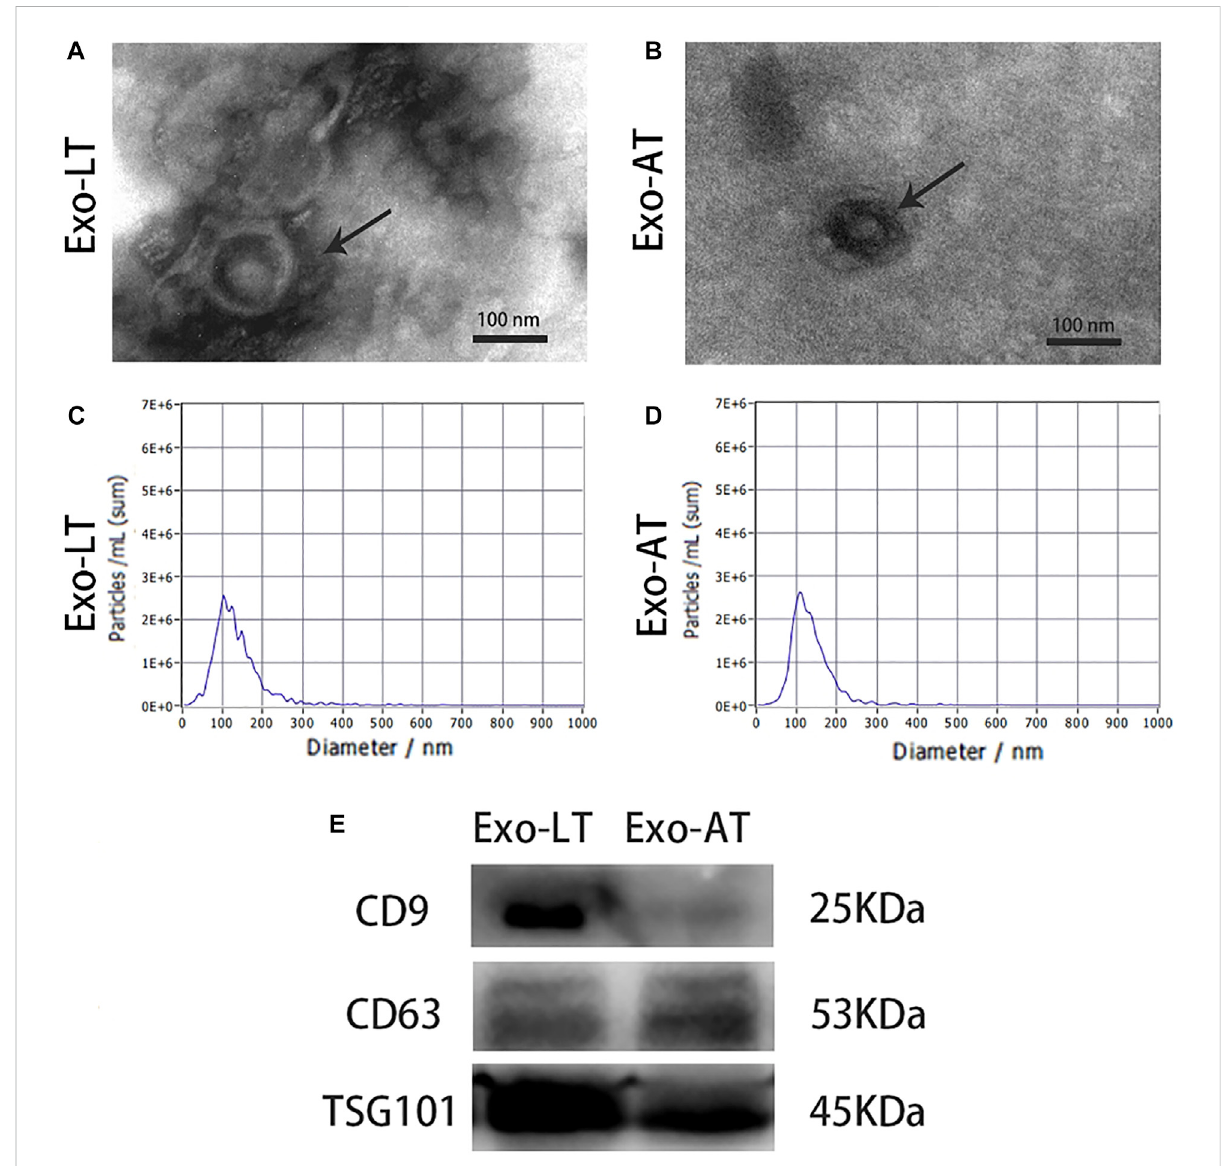
markers, CD9, CD63, and